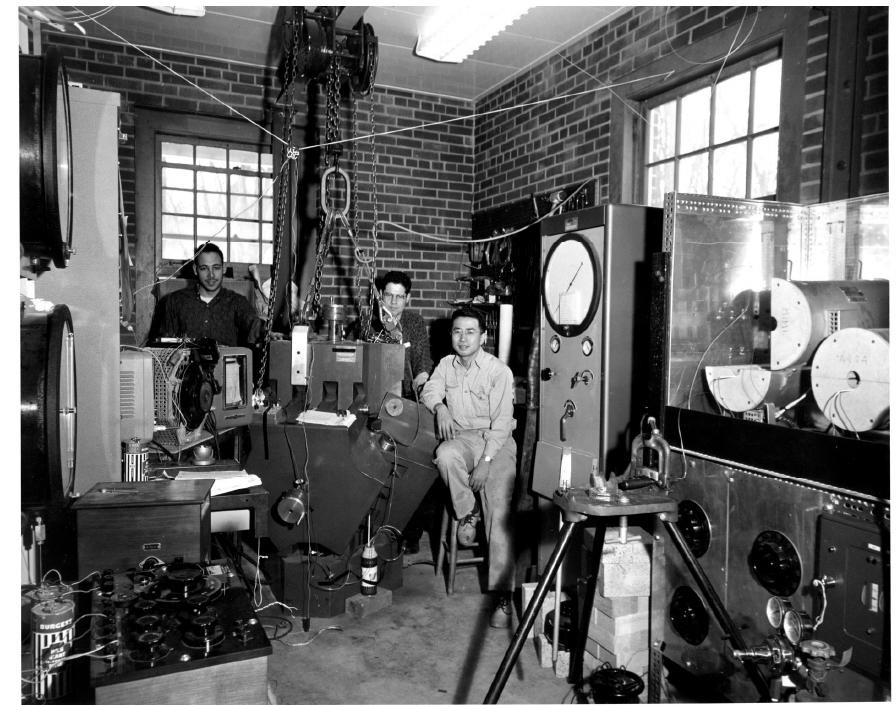
Figure 1. Alfred University, 1960: Taro Takahashi’s high-pressure lab equipped with a tetrahedral multi-anvil apparatus. Taro is on the right and his graduate student at the time, Ed Schreiber, is in the center. It was shortly after this (about 1963) that Taro accepted an offer at the University of Rochester and continued his high-pressure research, while Ed moved to Lamont Geological Observatory as a member of the research faculty to pursue high-pressure experiments in the Mineral Physics laboratory of Orson Anderson. (Photo courtesy of Taro Takahashi and Bob Liebermann).